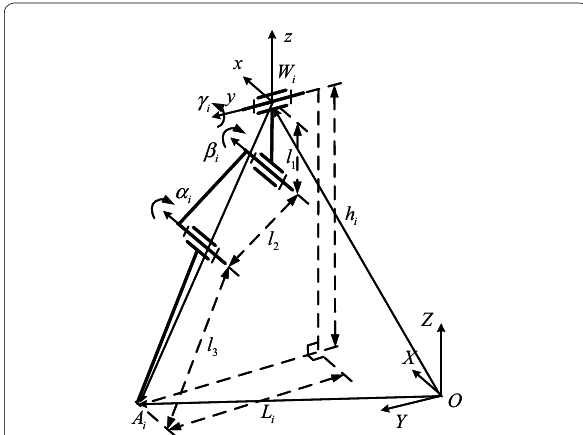
joint and fixed to the body of robot, and the foot refer- ence frame { A i } is located at the foot of the supporting leg i . The configuration when the leg is fully extended is regarded as the home configuration. In this position, all the joint variables are set to zero.